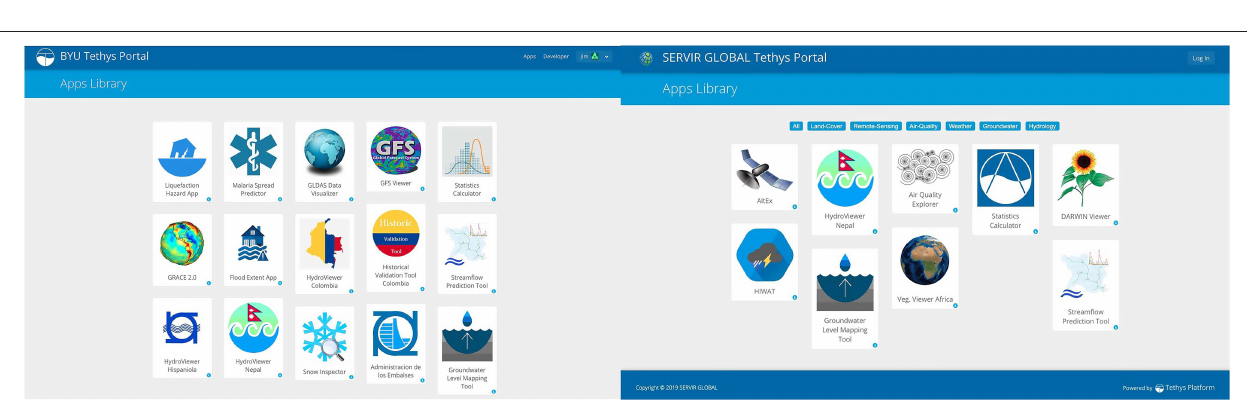
FIGURE 5 | BYU Tethys portal (Left) and SERVIR global Tethys portal (Right)